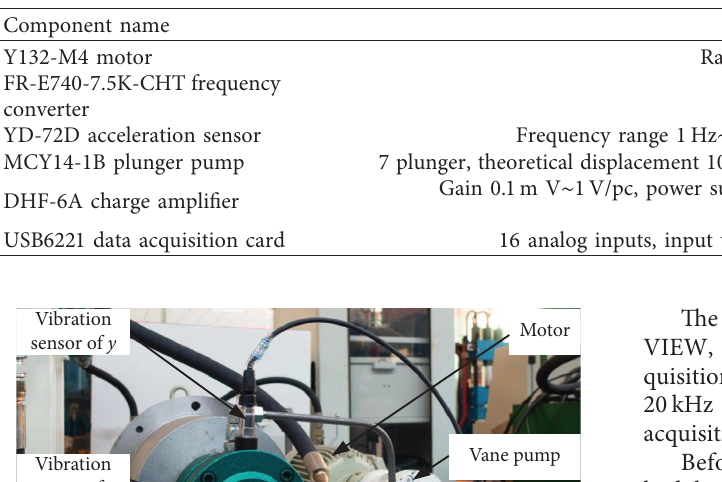
Figure 10: Hydraulic schematic diagram of hydraulic pump failure simulation test bench. Table 2: Main components involved in the test bench.